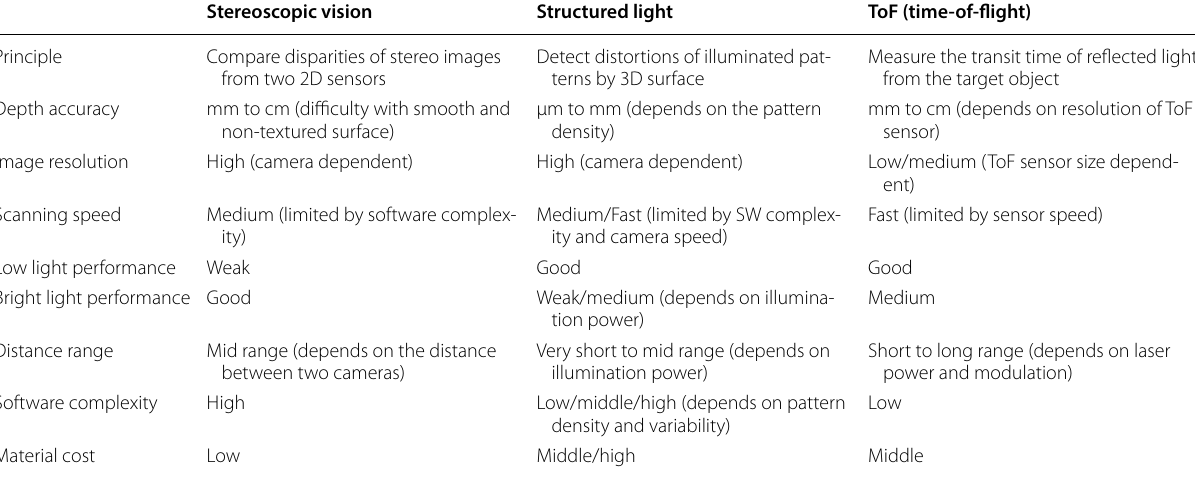
Table 1 Distinctive aspects of three representing techniques for 3D surface imaging [13–18] Stereoscopic vision Structured light ToF